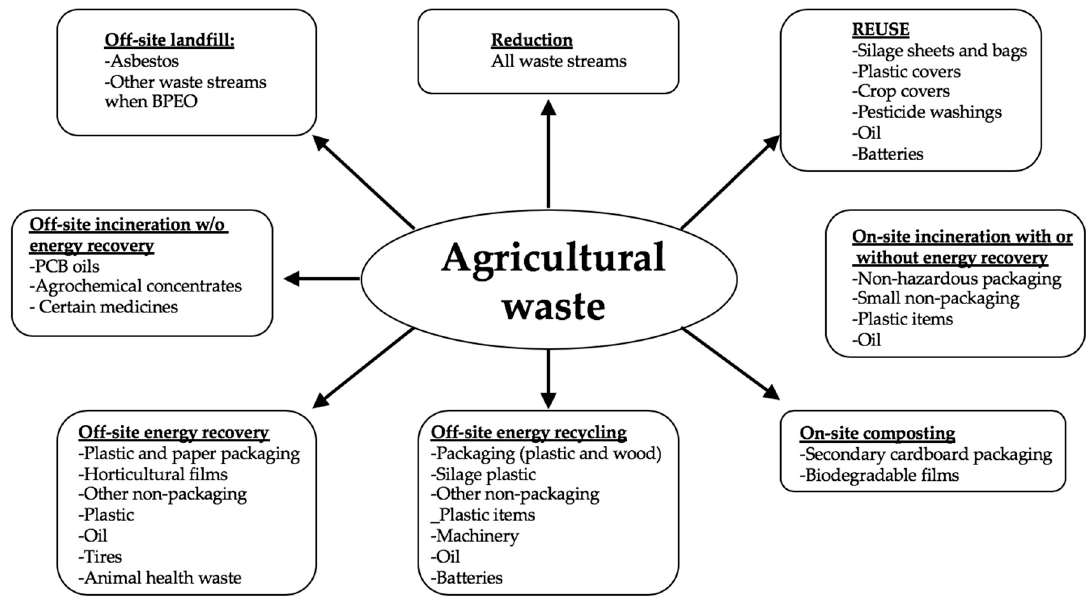
Figure 1. An overview of different options for agricultural waste management (after [4]).